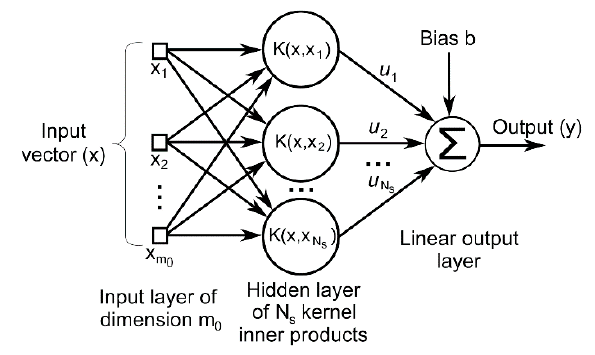
Figure 8. Support vector machine structure.